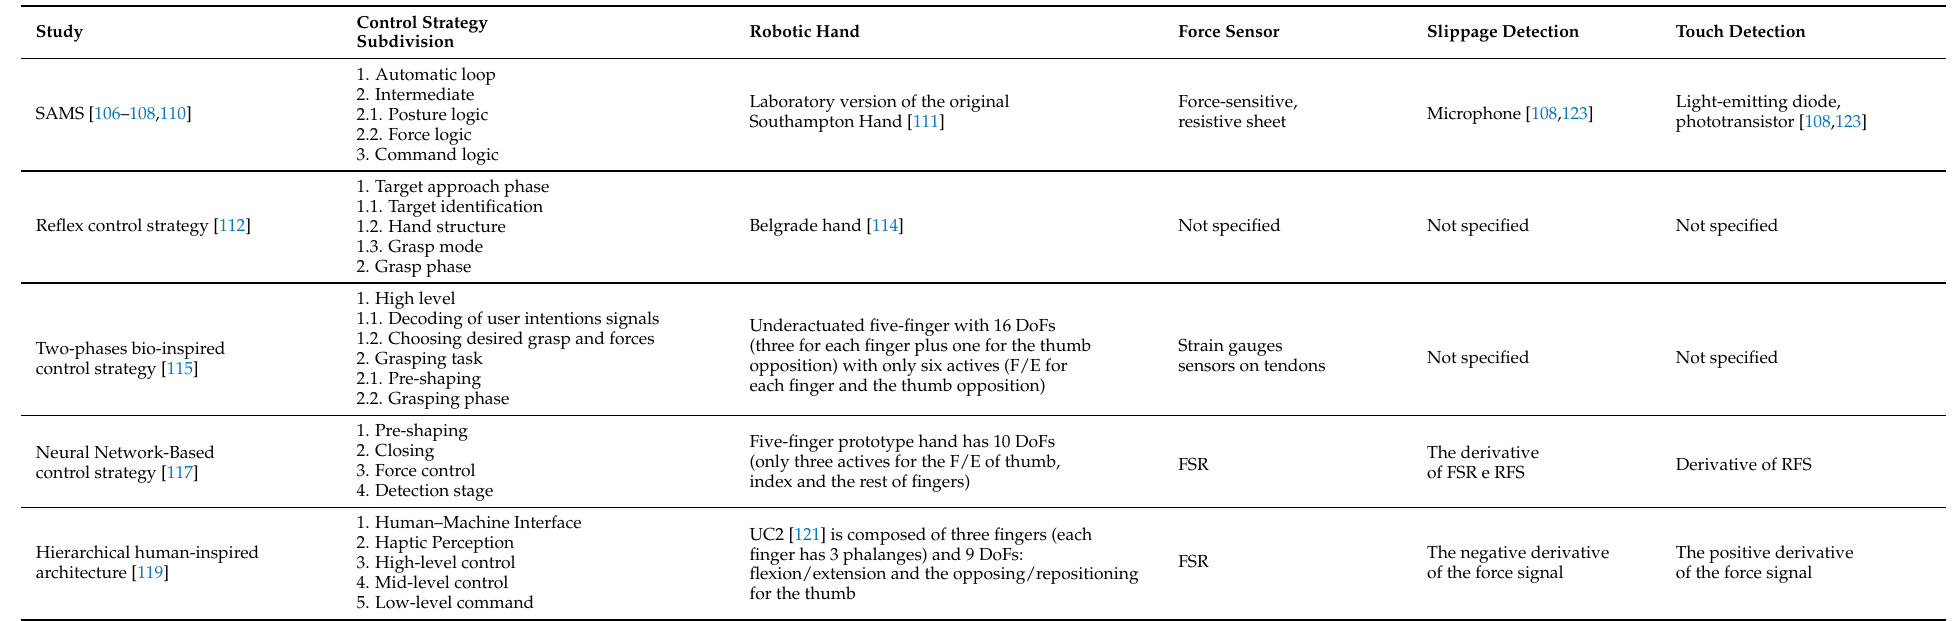
Table 4. Summary of the reported